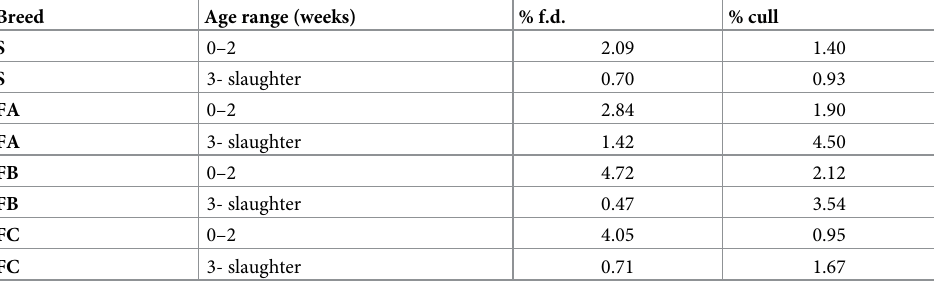
Table 5. The percentages of birds that were either found dead or culled during the first two weeks of age and from three weeks of age to slaughter for the different breeds. Breed Age range (weeks) % f.d.